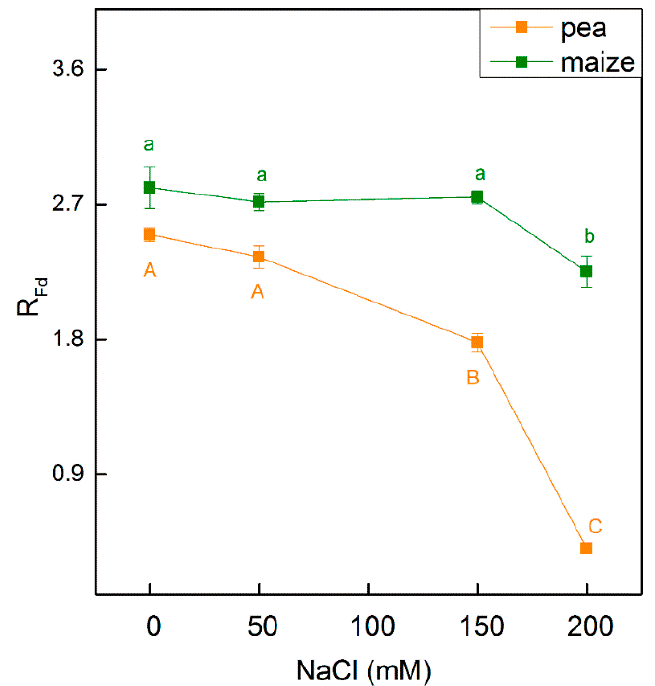
Figure 6. Effects of different NaCl concentrations on the chlorophyll fluorescence decay ratio R Fd in leaves of pea and maize. The parameter is in relative units. Mean values (±SE) are from 10 independent measurements. Different letters indicate significant differences for the respective parameters at p < 0.05 (uppercase for pea and lower case are for maize).